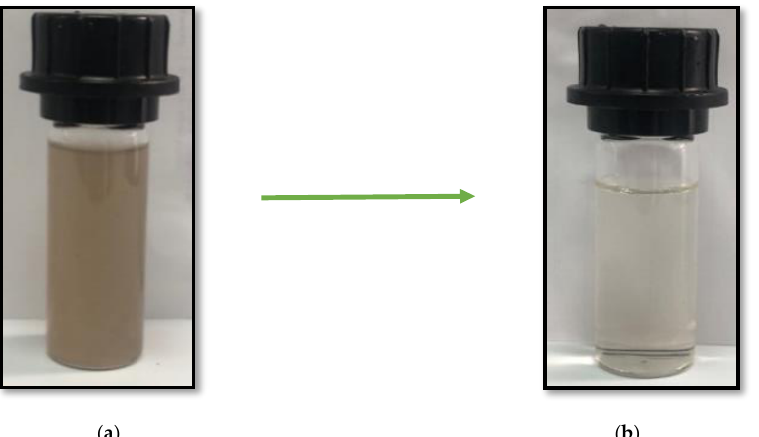
Figure 26. UV-Vis absorbance of treated FW vs. coagulant dose at three different wavelengths: 436, 525 and 620 nm.